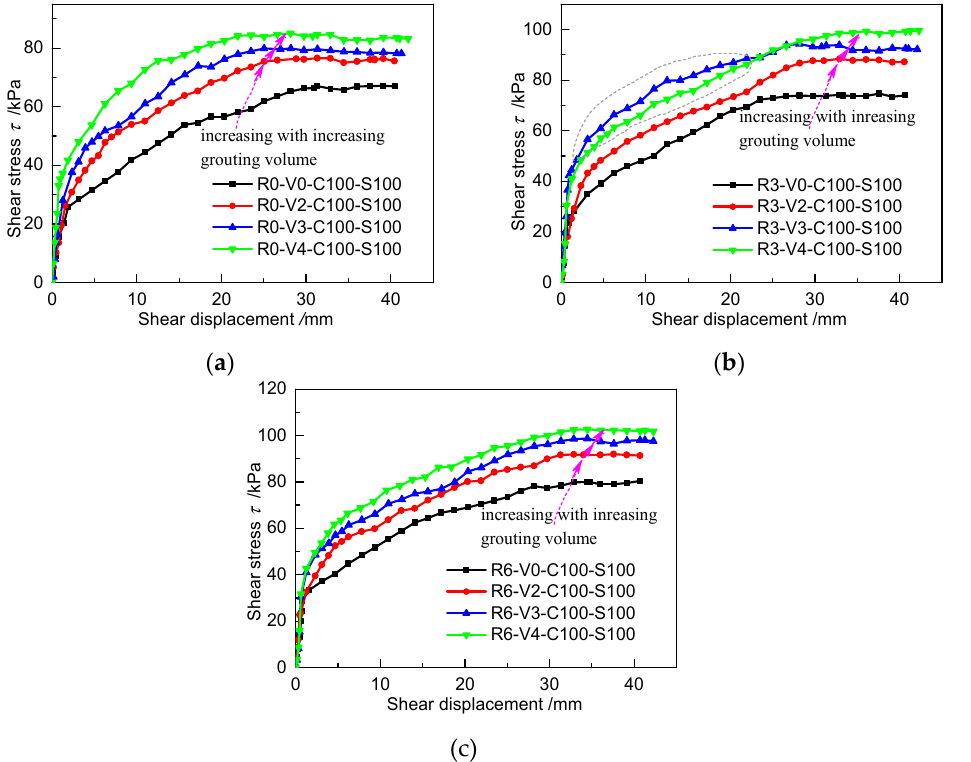
Figure 10. Shear stress–displacement curves ( τ – s curves) for specimens with different grouting volumes: ( a ) R0, C100 and S100; ( b ) R3, C100 and S100; ( c ) R6, C100 and S100.